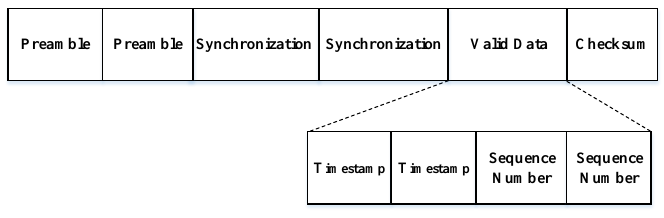
Figure 3. Modified synchronization